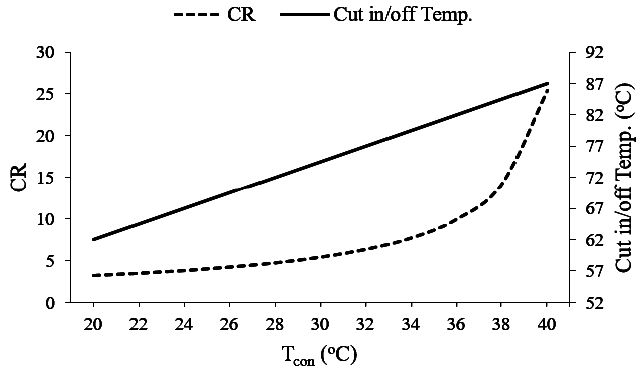
Figure 12. Variation of cut in/off temperature and CR with T con .